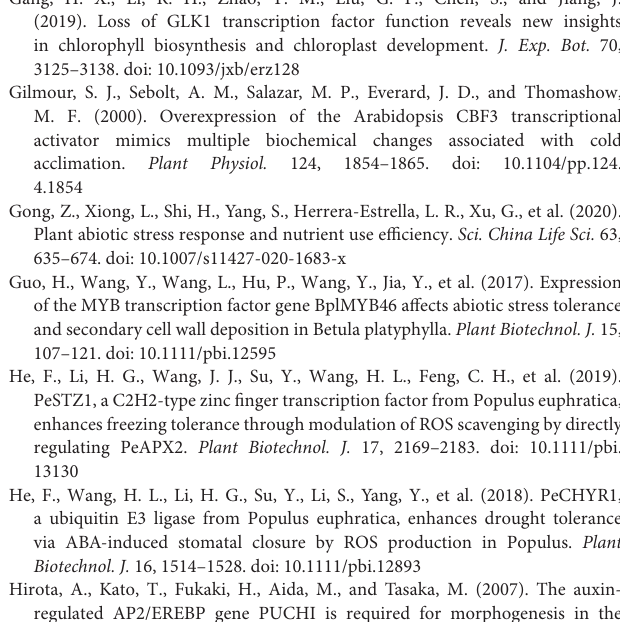
Supplementary Table 3 | DEGs in WT_S vs. WT. Supplementary Table 4 | DEGs in OX vs. WT. Supplementary Table 5 | Expression and gene annotation of